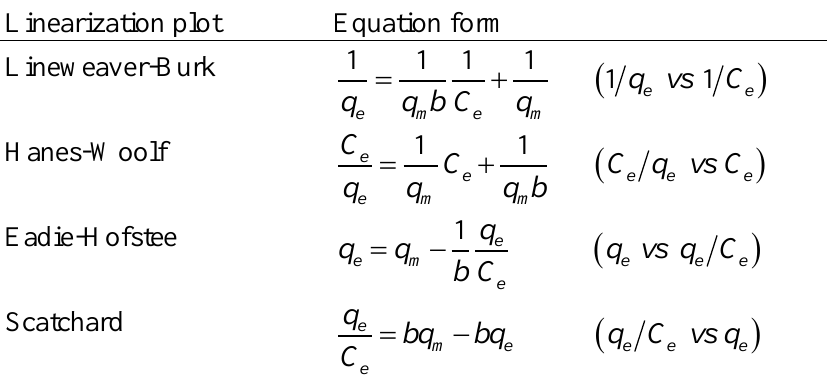
Table 1. Four linearized forms of the Langmuir equation.